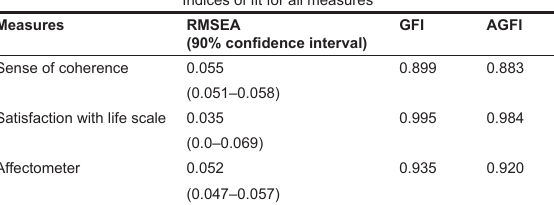
TABLE 3 Indices of fit for all